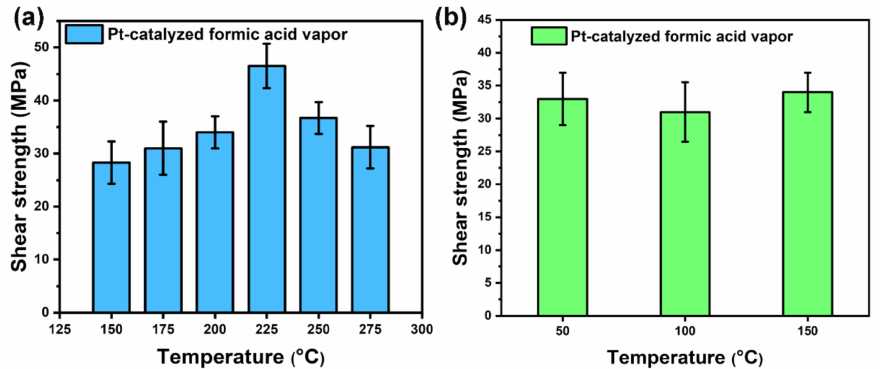
Figure 6. ( a ) The shear strength of Ag-plated copper substrates sintered at different temperature for 30 min in Pt-catalyzed formic acid vapor, and ( b ) the shear strength of Ag paste preheated at different temperatures for 5 min and then sintered at 200 ◦ C for 30 min in Pt-catalyzed formic acid vapor.